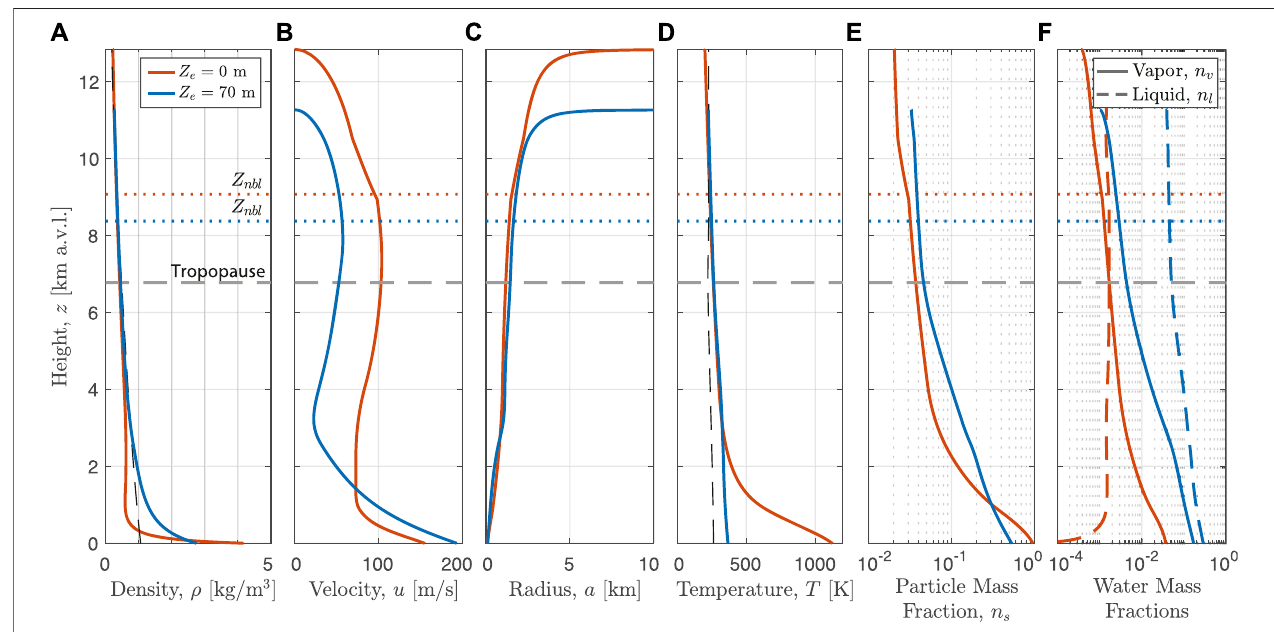
FIGURE7| Exampleplume model output fromthe Reference set(see Table 2 )versusheightabove theventforapair ofsimulations:red linesshow a “ dry ” control runwith a c =20.0m, Z e =0,and Q 0 =1.00×10 7 kg/s.Bluelinesshowahydrovolcanicscenariowith a c =20.0m, Z e =70m,and q c =1.01×10 7 kg/s(bluelines). (A) Bulk density. (B) Verticalvelocity. (C) ColumnRadius. (D) Bulktemperature. (E) Particlemassfraction. (F) Waterliquidandvapormassfractions.Horizontaldottedlinesshow the level of neutral buoyancy for each case, and the horizontal dashed gray line shows the height of the tropopause (note y-axis is kilometers above vent level).